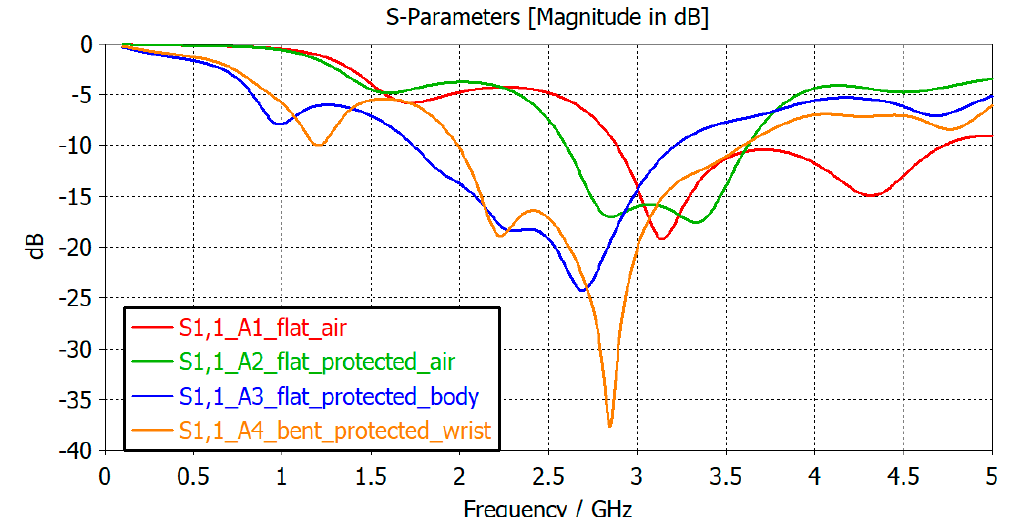
Figure 4. Simulated reflection coefficient of the proposed antenna in four scenarios: A1 placed in air; A2 protected by varnish and silicon; A3 placed on human body; A4 bent on human’s wrist.